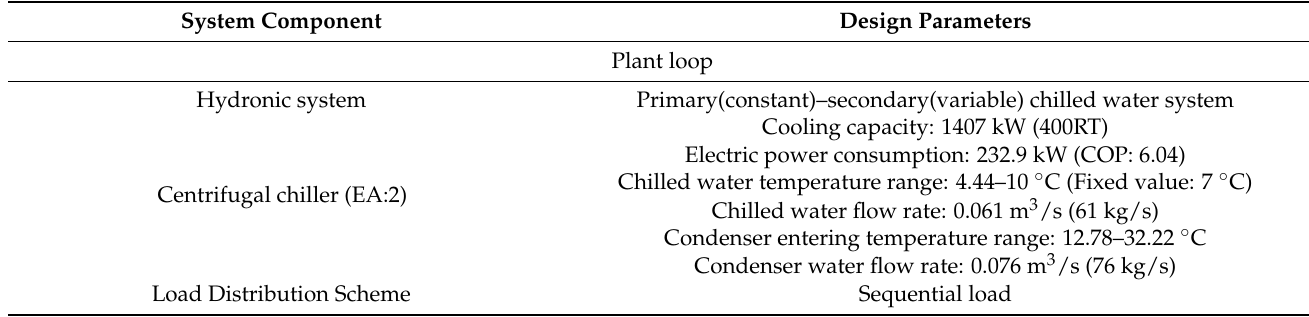
Table 3. Design parameters of central chilled water